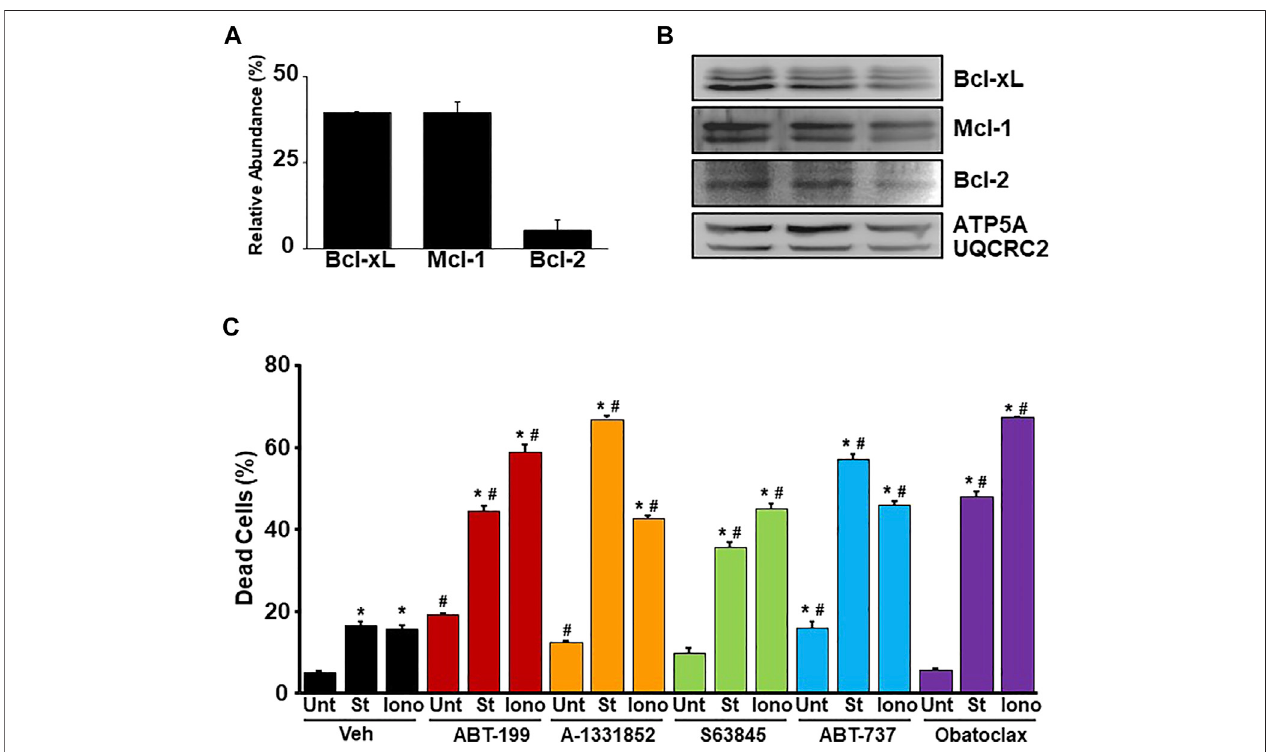
FIGURE1| BH3mimeticssensitizeMEFstoapoptosisandnecrosis. (A) Quantitationoftherelativeabundanceofanti-apoptoticBcl-2familymembers(Bcl-2,Bcl- xL, and Mcl-1) from enriched mitochondrial fractions isolated from WT MEFs measured by tandem-mass-tagging mass spectrometry (n (cid:2) 5). (B) Western blots for anti- apoptotic Bcl-2 family proteins (Bcl-2, Bcl-xL, and Mcl-1) and Ox. Phos. (ATP5A and UQCRC2) (loading control) using enriched mitochondrial lysates isolated from WT MEFs. (C) Flow cytometer analysis of cell death measured by PI positivity of WT MEFs treated with BH3 mimetic (30 μ M ABT-199, 10 μ M A-1331852, 10 μ